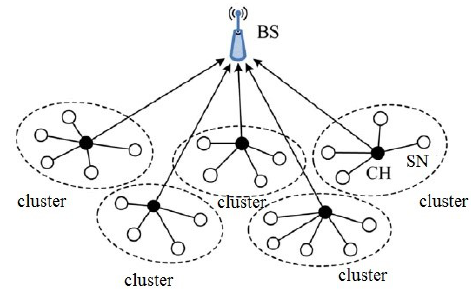
Figure 1. Wireless sensor network